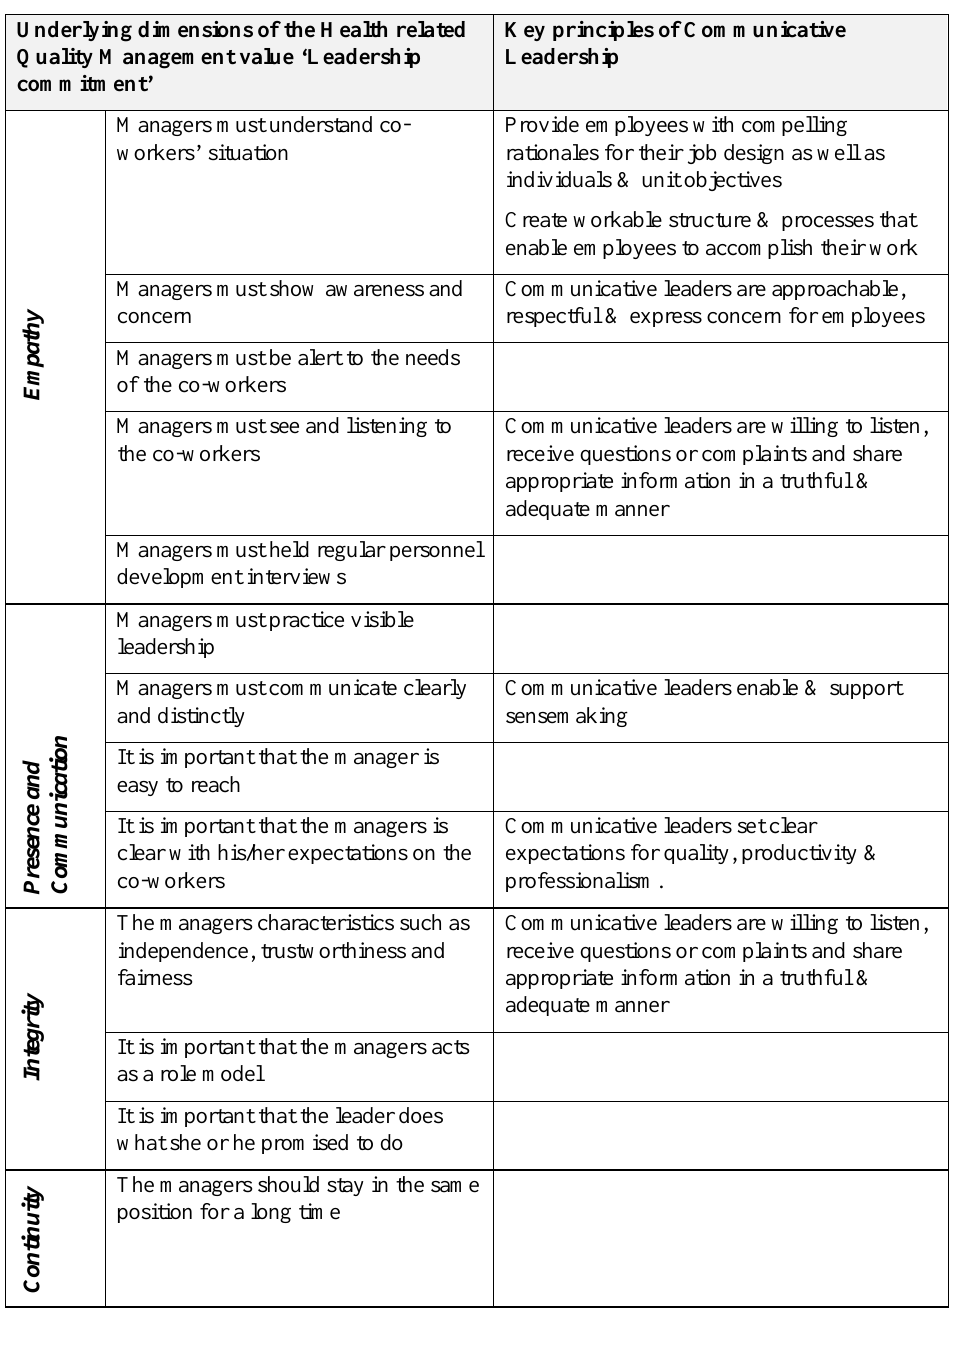
Table 1 – The analysis of the underlying dimension of the health related Quality Management value ‘Leadership commitment’ versus the description of the key principles of Communicative